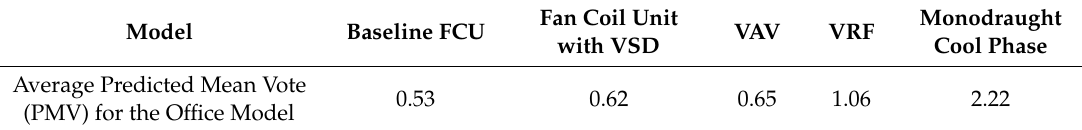
Table 16. Average Predicted Mean Vote (PMV) for different cooling systems.